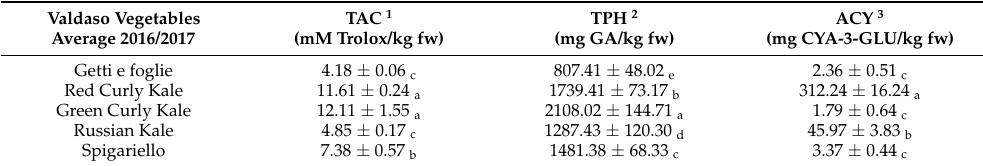
Table 8. Phenolics, anthocyanins contents and antioxidant capacity in the different type of vegetables analyzed during the two years of trials in Valdaso. Valdaso Vegetables Average